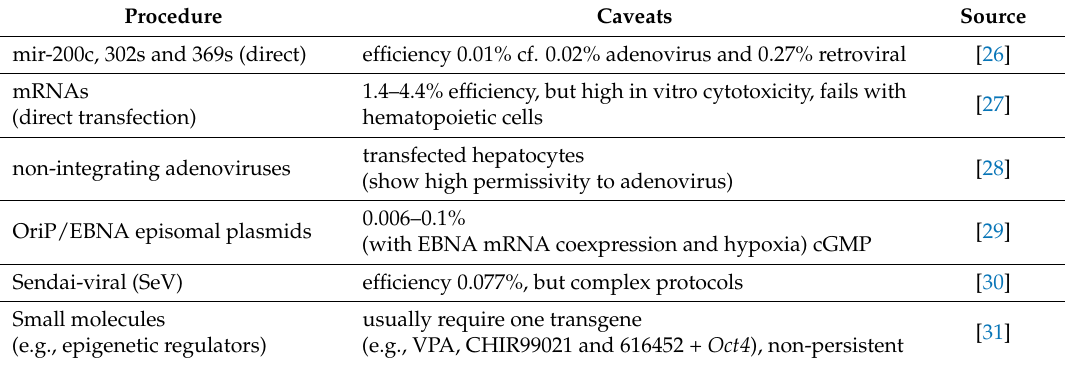
Table 1. Reprogramming strategies developed to avoid transgene integration, and most commonly used in the production of iPSC. Abbreviations: cGMP, Good Manufacturing Practice certified; EBNA, Epstein–Barr Nuclear Antigen 1; miR, micro-RNA. Sources used in compilation of the table are given in the rightmost